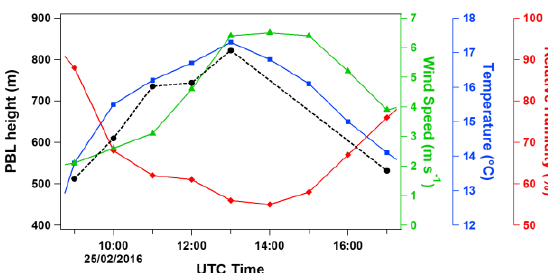
Figure 4 Temporal evolution of the hourly means of PBL height from RCS-SD (black dots), wind speed (green triangles), air temperature (blue boxes), and relative humidity (red